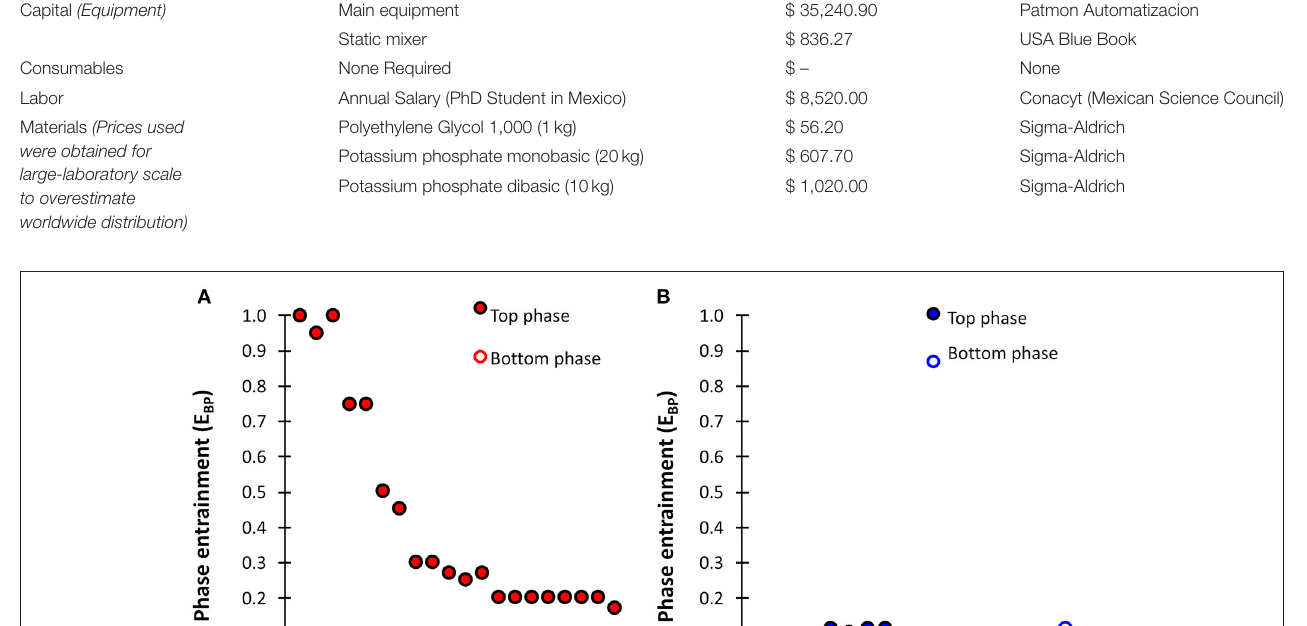
documented for invertase and other enzymes when recovered using ATPS (Cavalcanti et al., 2006; Babu et al., 2008; Porto et al., 2008; Madhusudhan and Raghavarao, 2011; Nandini